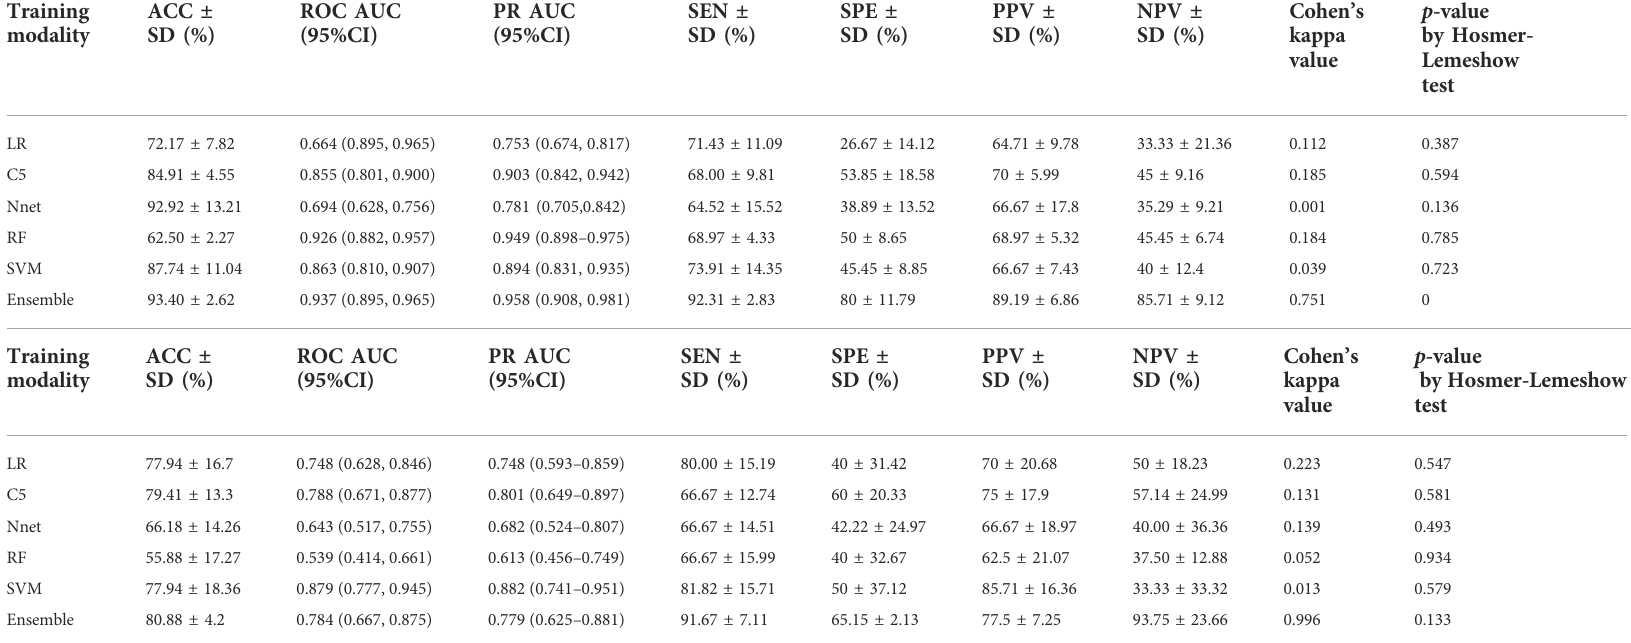
TABLE 4 Results from 5-fold cross-validation of predictions renal de fi